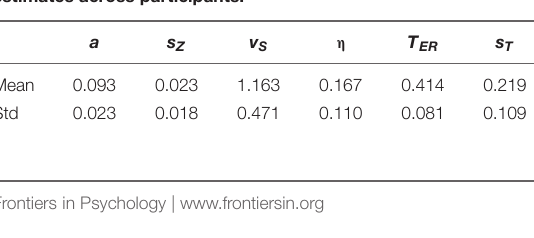
TABLE 1 | Mean and standard deviation of the diffusion model parameter estimates across